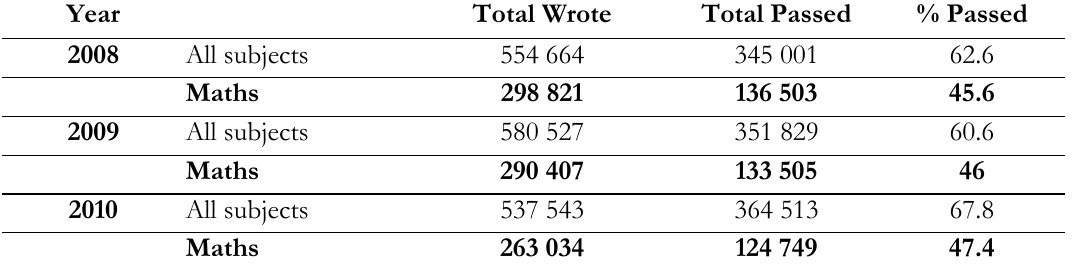
Table 1 . National Senior Certificate Pass Rates In All Learning Areas (Mathematics statistics Interpolated): 2008 to 2010 Educational Measurement, Assessment and Public Examinations